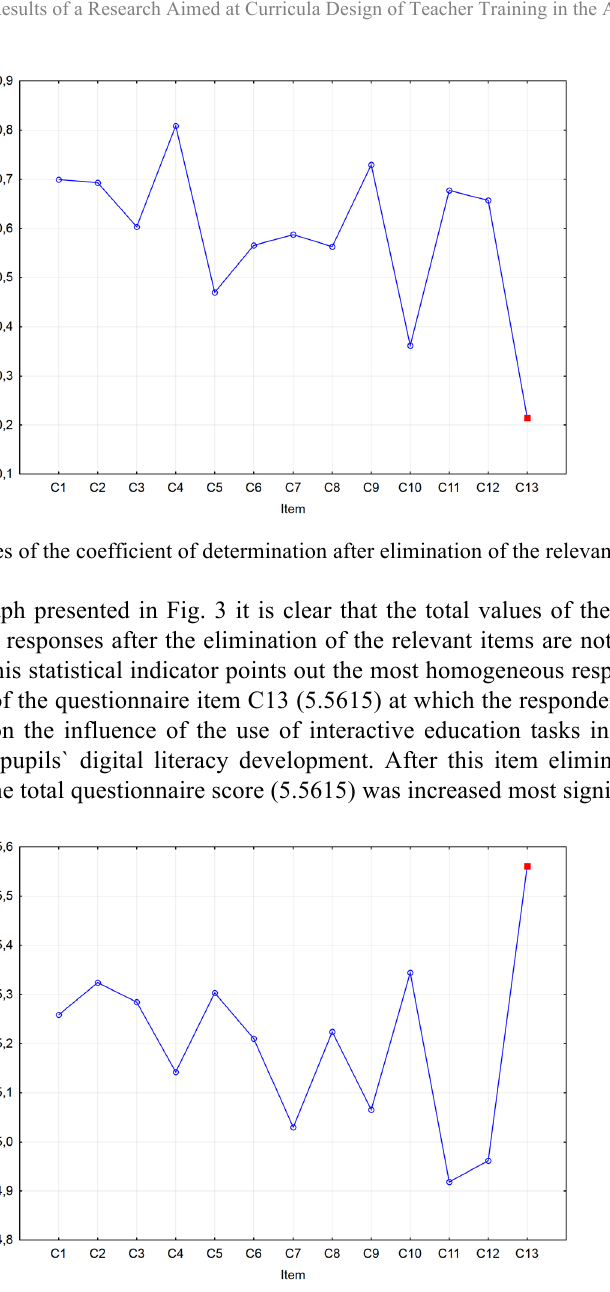
Fig. 3. Values of the total score standard deviation after the relevant item